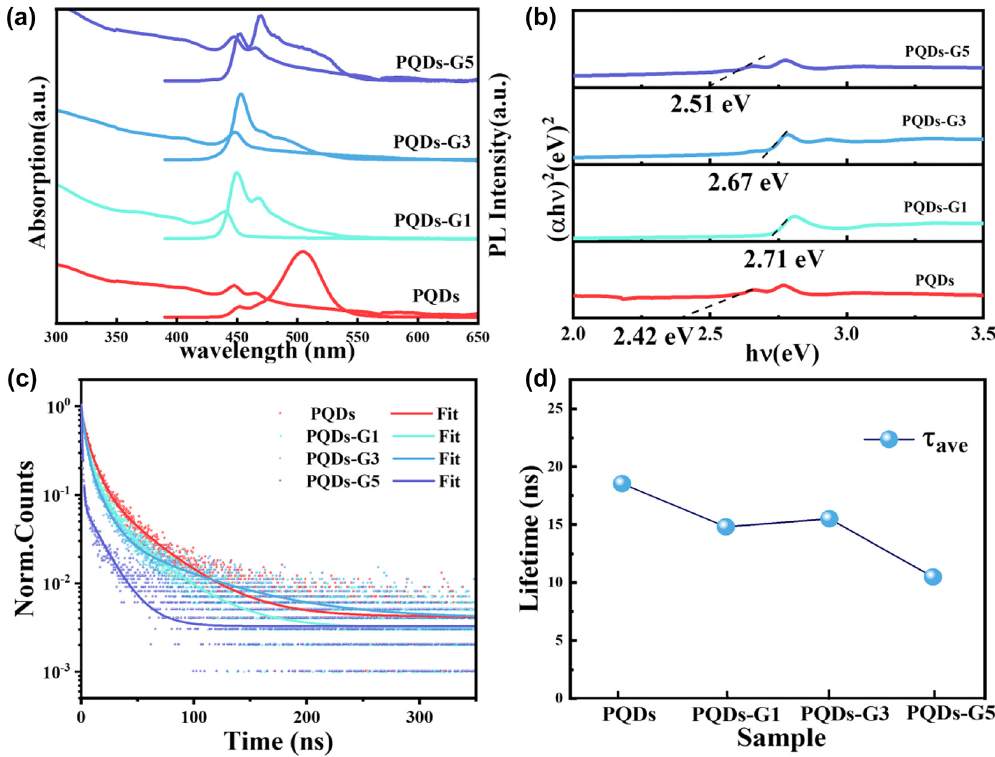
Figure 4: (a) The UV–Vis absorption (left) and PL spectra (right) of PQDs and PQDs-G composites. (b) Tauc plot of all samples. (c) PL decay profiles of all samples. (d) Average fluorescence lifetime of all